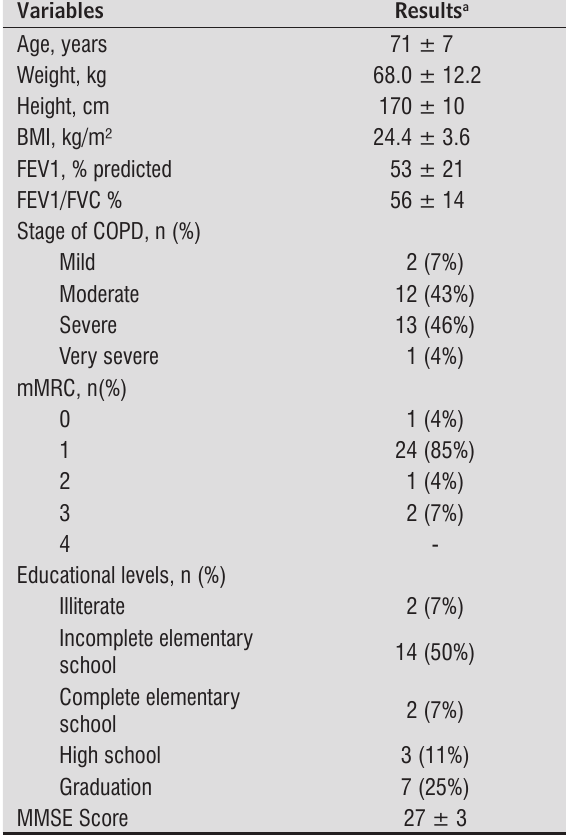
Table 1 - Characteristics of the studied